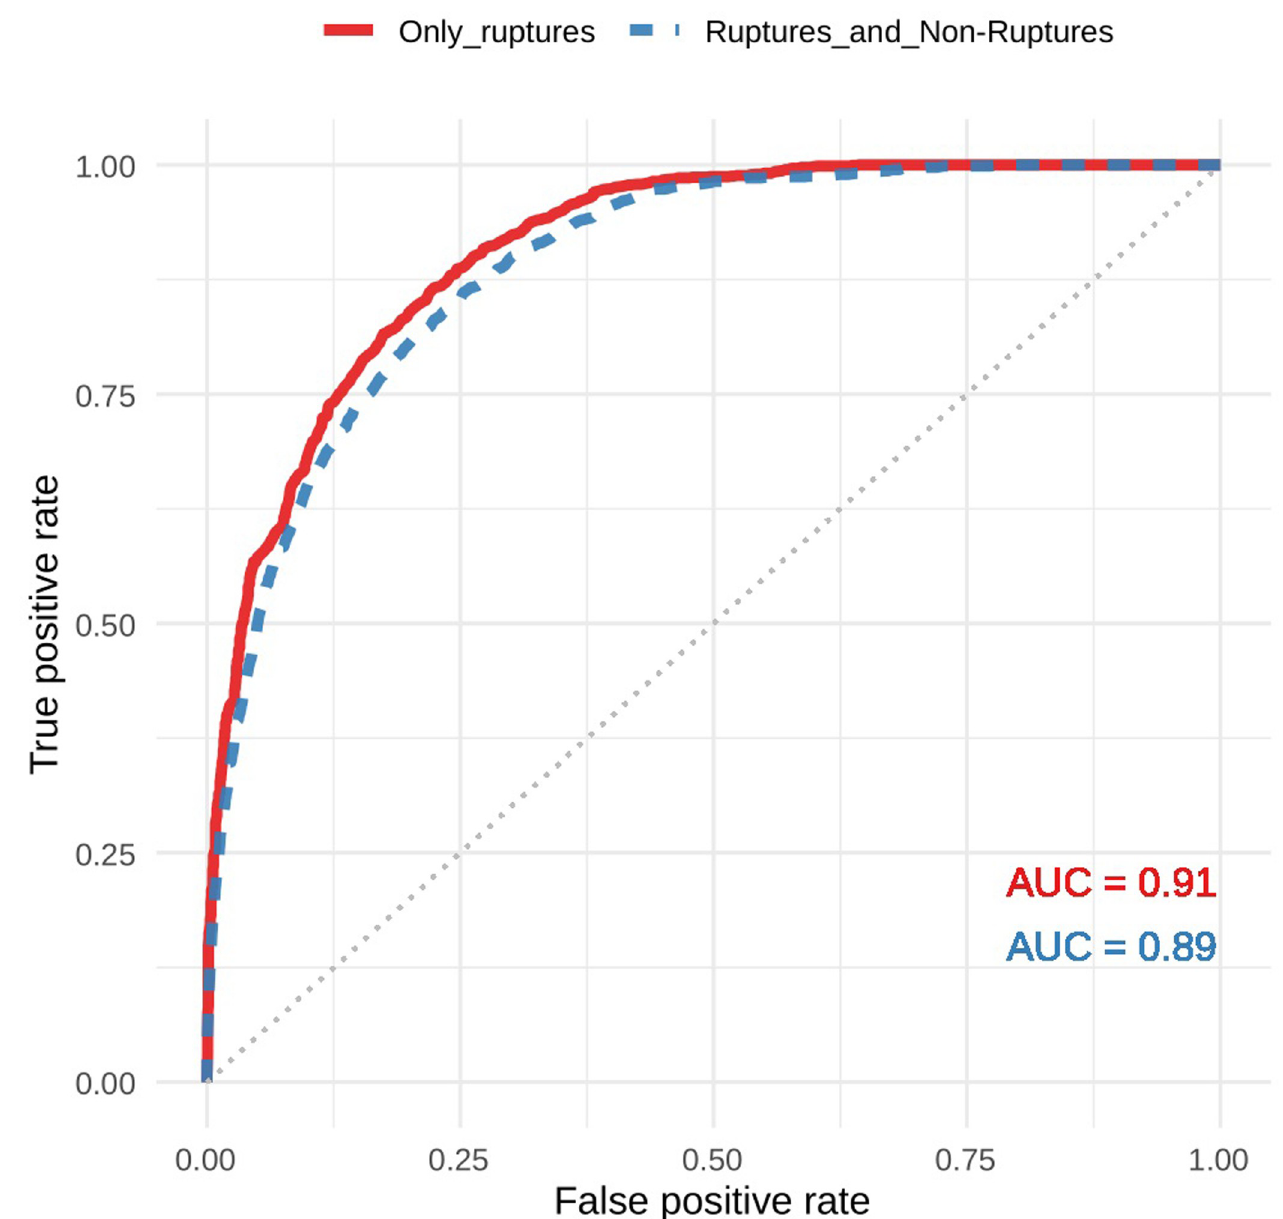
Fig 4. ROC for the prediction of minimal response markers in the validation data sets. Fig 4 shows the ROC for the minimal response marked rupture- prediction in the validation sets, constructed by plotting the true positivity rate against the false positive rate. The red line presents the performance in the validation set which only included ruptures. The dashed blue line presents performance in a validation set in which non-rupture data (by definition containing no minimal response markers) were added.